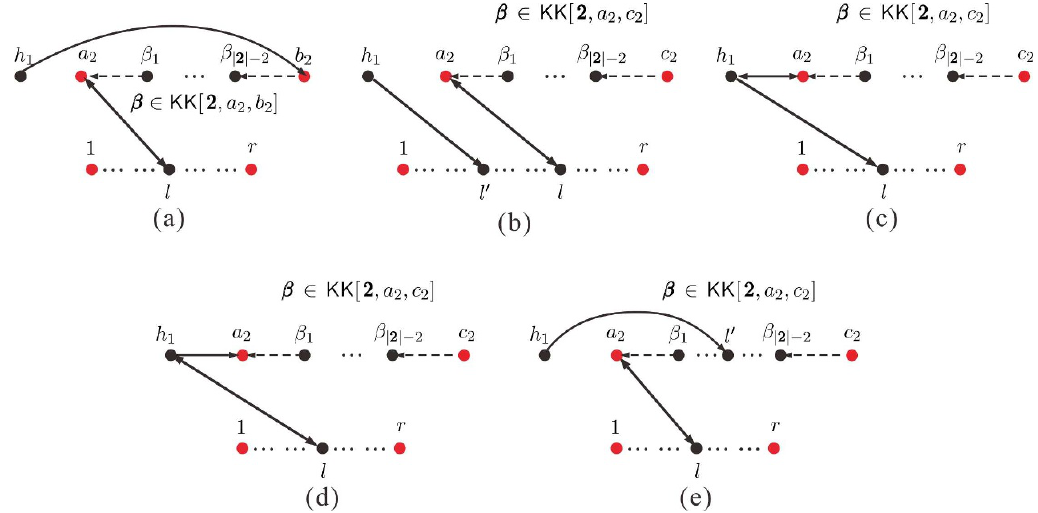
Figure 4 . Typical graphs for the pure YM expansion of the amplitude A (1 ; 2 : : : r j 222 k h 1 ). Graphs of structures (a), (b) and (c) contribute to the expansion with the reference order R = f 222 ; h 1 g . Graphs (b), (c), (d) and (e) contribute to the expansion with the reference order R = f h 1 ; 2 2 2 g